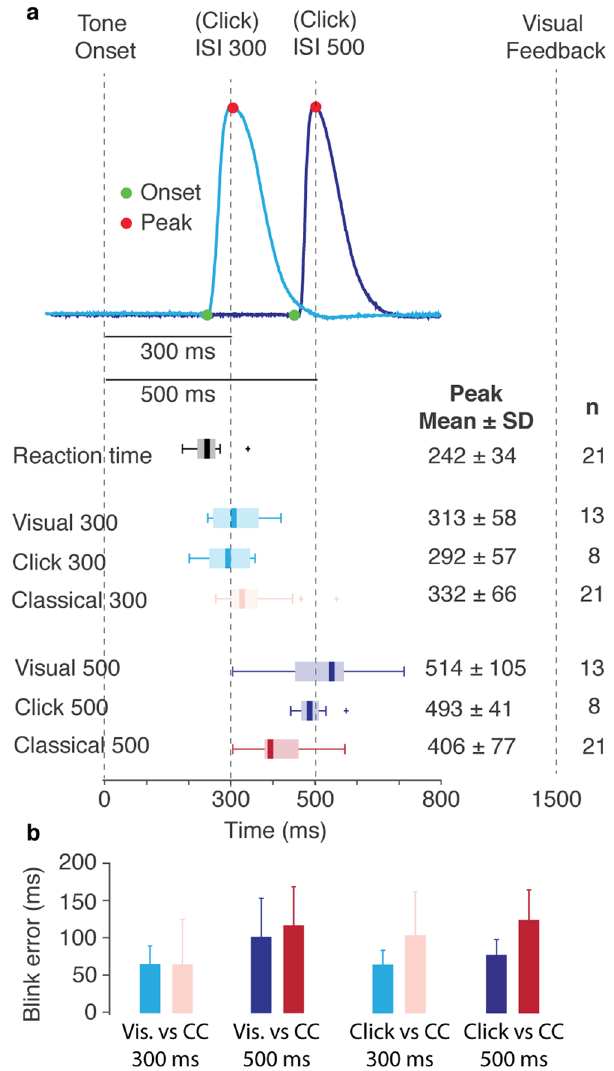
Figure 4. Timing comparisons. ( a ) Top: Two blink responses produced after training in the click paradigm with two different delays, 300 ms (light-blue) and 500 ms (dark-blue). Green and red markers denote the identified onset and peak respectively. Bottom: Boxplots illustrating the timing of the peak in the different paradigms. ( b ) The timing error variability on CS alone trials for the different training paradigms and target